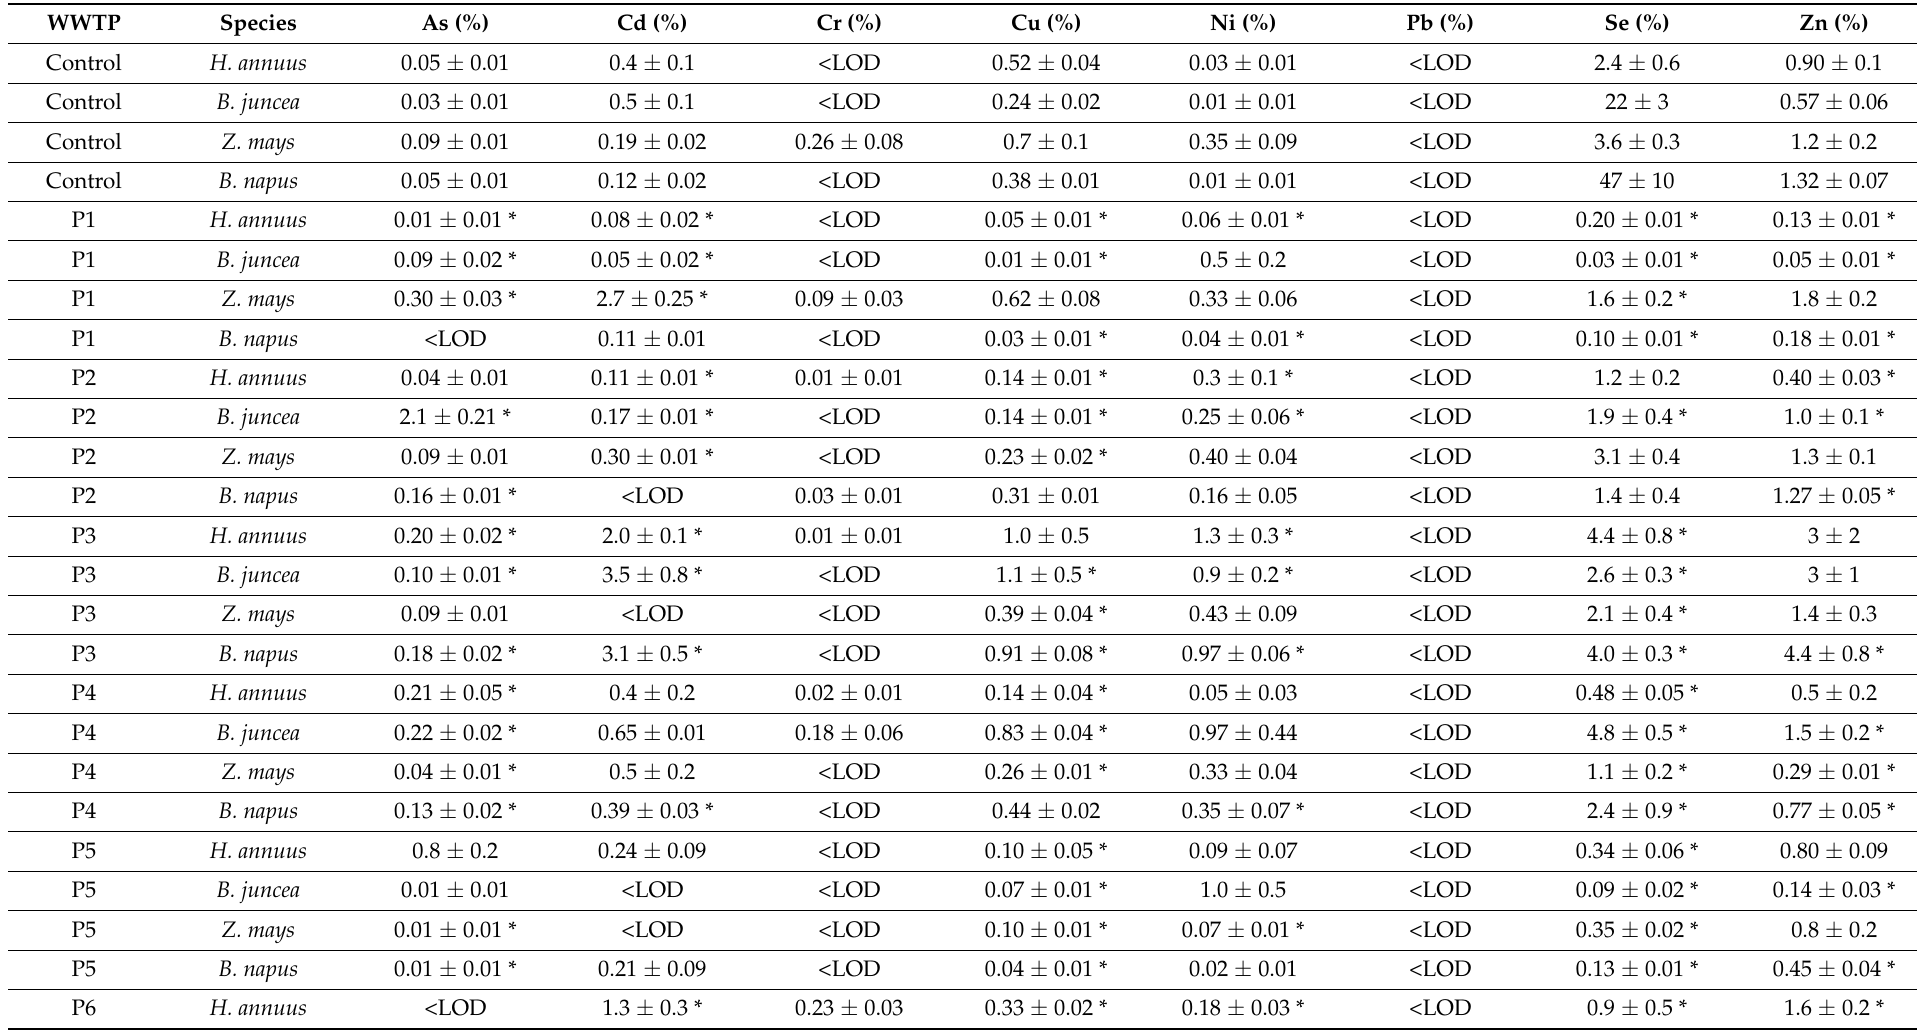
Table 4. Metal removal after phytoremediation. Values are the average of 5 replicates ( n = 5). WWTP, wastewater treatment plant; LOD, limit of detection. Stars indicate significant differences in metal removal (%) with respect to the control, within the same species (T/Wilcoxon test, p < 0.05). Complete dataset in Supplementary Table